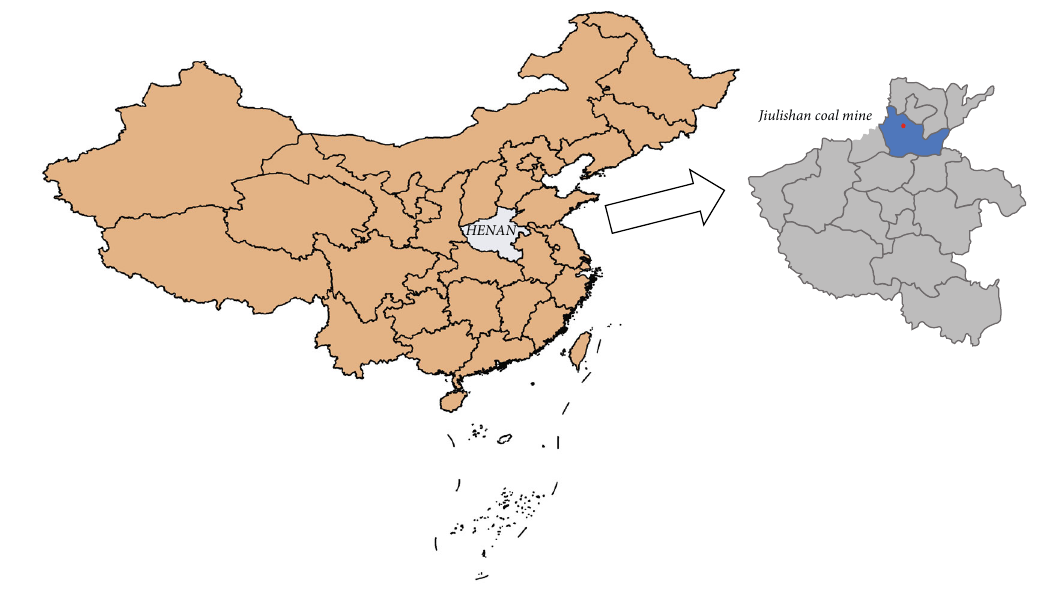
Figure 1: Location of Jiulishan coal mine.